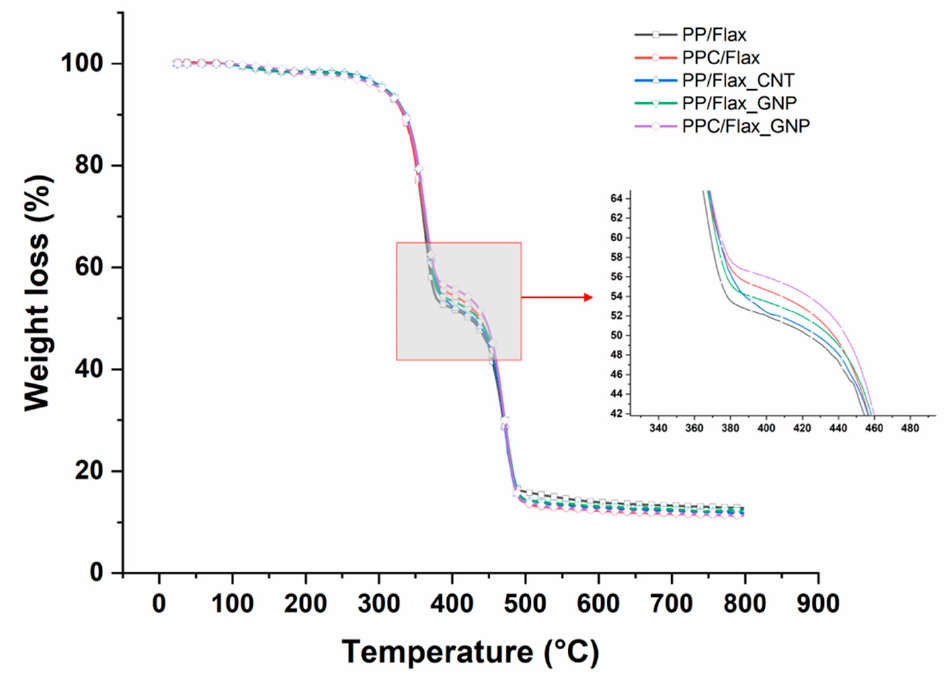
Figure 10. Thermograms for the different PP/flax composites.